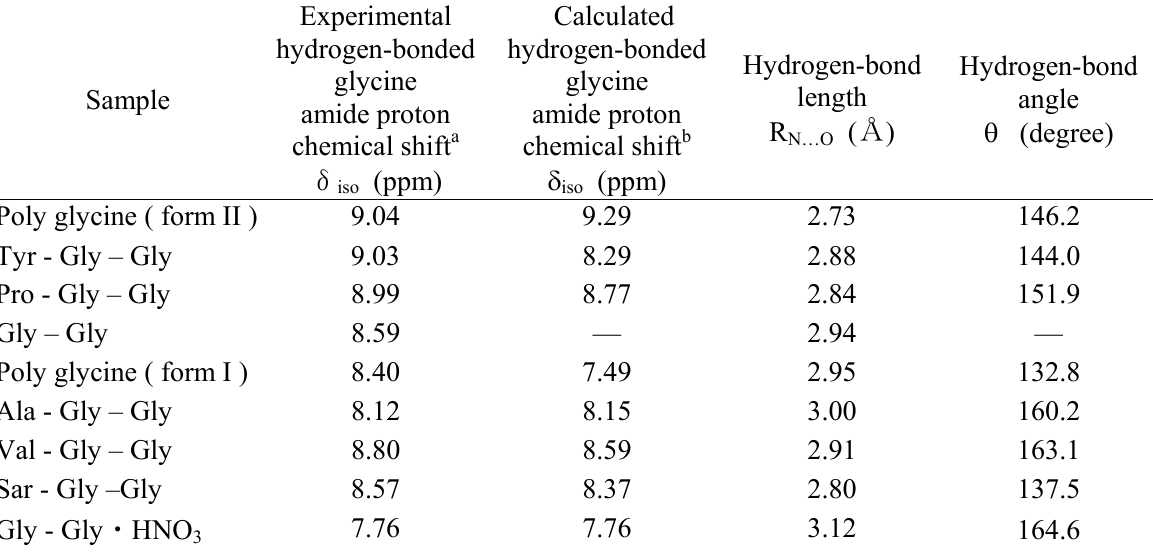
Table 2. Calculated 1 H chemical shifts of the amide proton of a supermolecule, an N-methylacetamide hydrogen-bonded with a formamide, as functions of hydrogen-bond length R angles by FPT-GIAO method within the framework of HF/STO 6-31 ++ G(d,p) ab initio MO method together with the experimental data reported previously